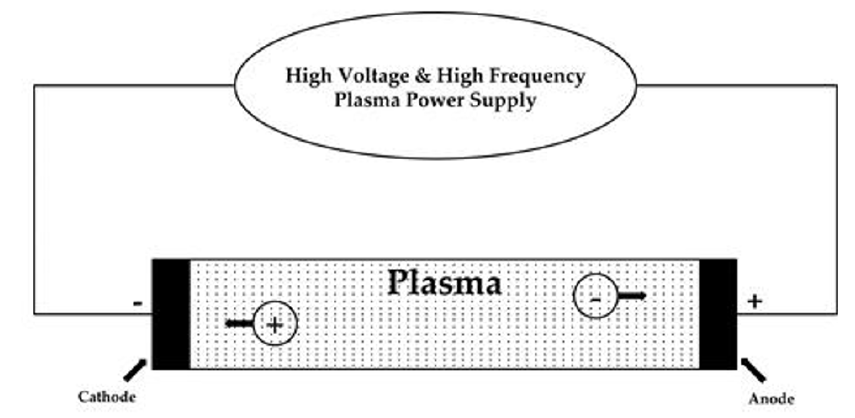
Figure 1. Simple representation of plasma discharge